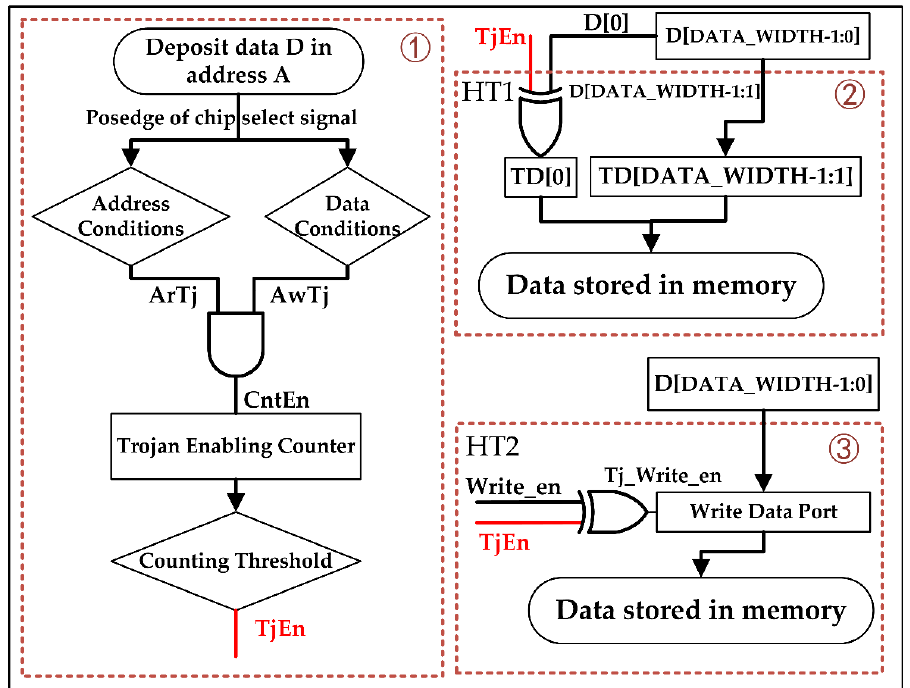
Figure 1. Hardware Trojan (HT)1 and HT2’s triggering and attack methods.